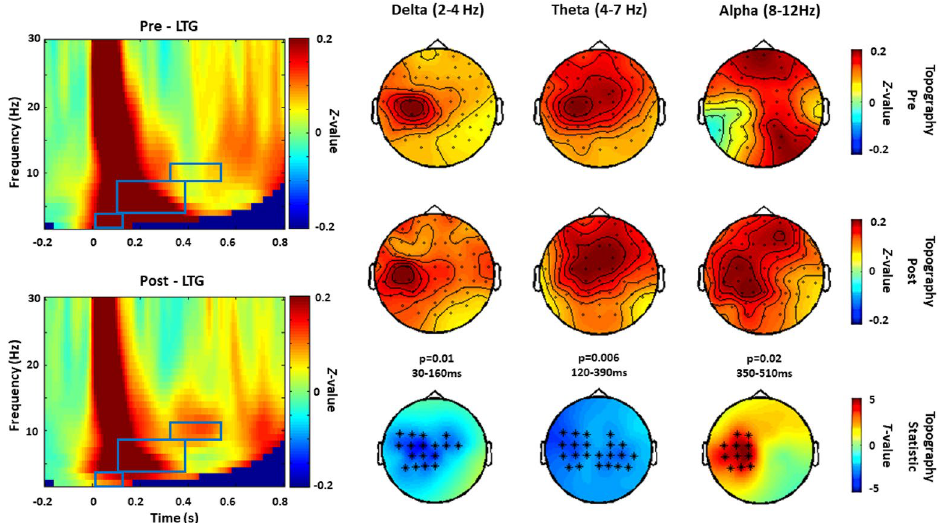
Figure 2. TRSP modulated by Lamotrigine (experiment 1). Grand averages of the time–frequency representation (TFR averaged over ROI channels) of TRSP recorded before (pre) and after (post) the intake of Lamotrigine are shown on the left panel. The blue boxes correspond to the time window when comparison between pre and post conditions showed significant drug effects. Topographical distributions of drug-related effects on delta (p = 0.01, 30–160 ms), theta (p = 0.006, 120–390 ms) and alpha band power (p = 0.02, 350– 510 ms) are reported for pre and post drug conditions on the right panel. Significant electrodes within the bilateral 27 electrode ROIs are represented with asterisks in the t-statistic map.